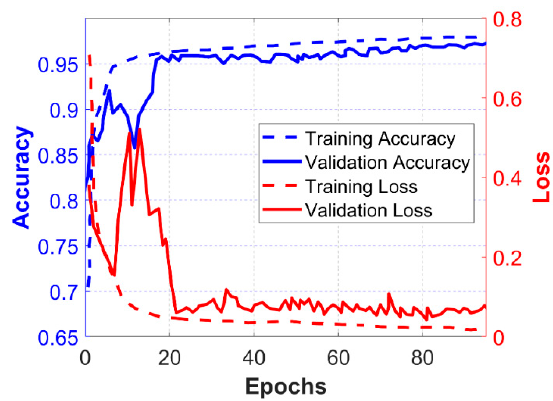
Figure 5. Training and validation curves of accuracy and loss of NSVM classifier. The x -axis denotes the training epochs.